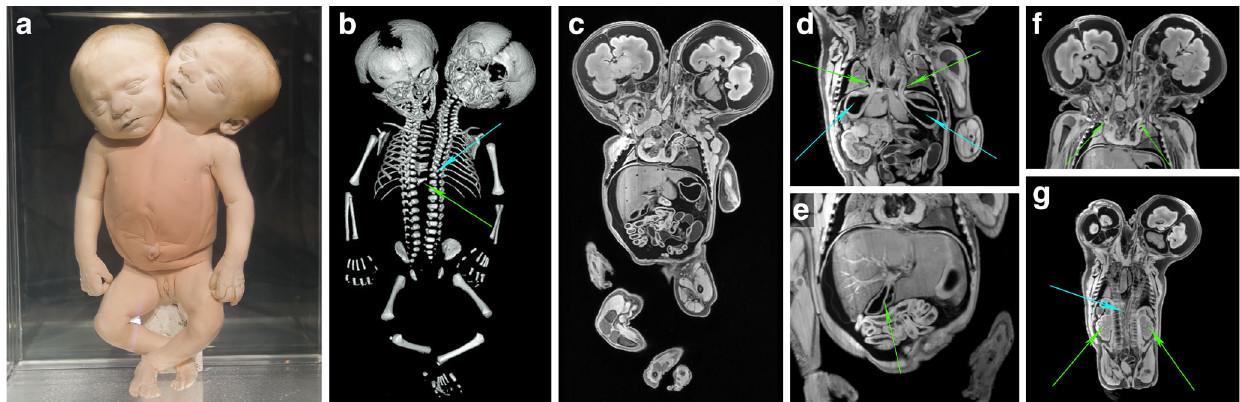
( turquoise arrow ). e Coronal T1-weighted MR image showed a B fused ^ liver with two gallbladders ( green arrow ). f Coronal T1-weighted MR image showed two ascending aortas ( green arrows ). g Coronal T1- weighted MR image showed two kidneys and adrenal glands ( green arrows ) and one anus. The two descending aortas fused at the level of the 11th thoracic vertebra ( turquoise arrow ). Note that the right descend- ing aorta is smaller than the left descending aorta